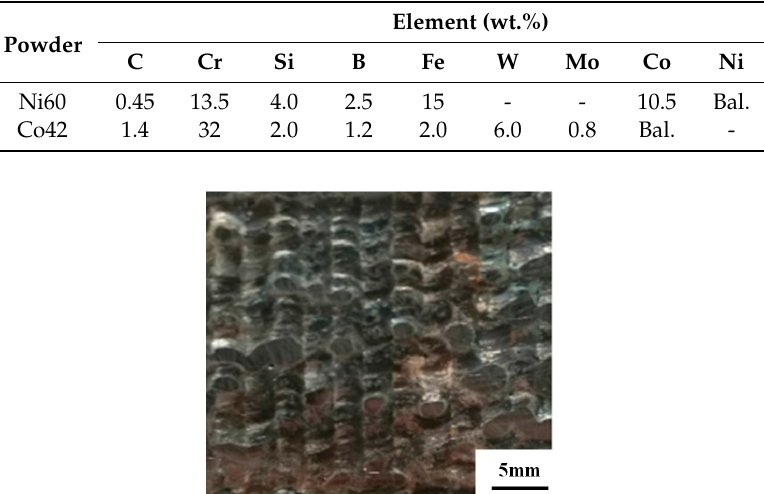
Table 1. Elemental composition (wt.%) of Ni60 and Co42 alloy powder.